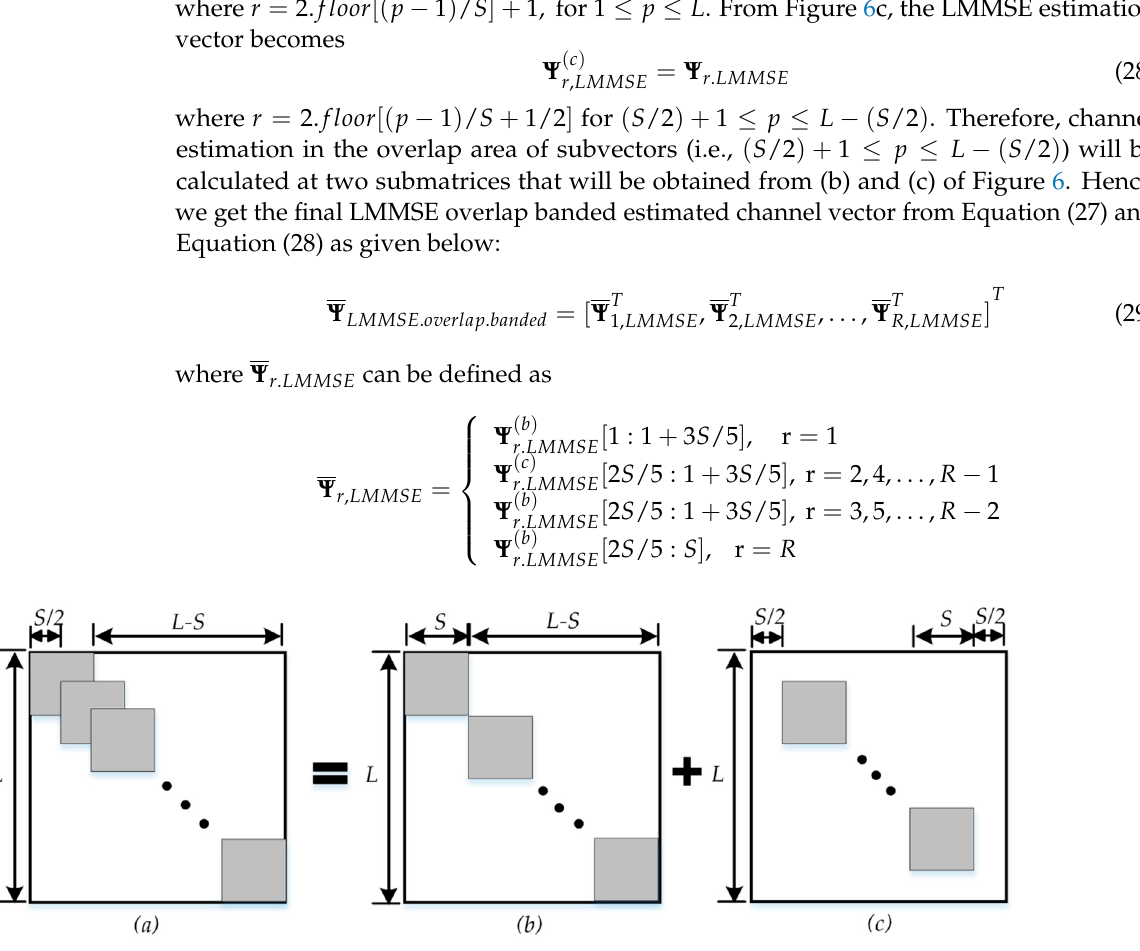
Figure 6. Splitting of the channel autocorrelation matrix ΨΨ Φ by applying the overlapping method.